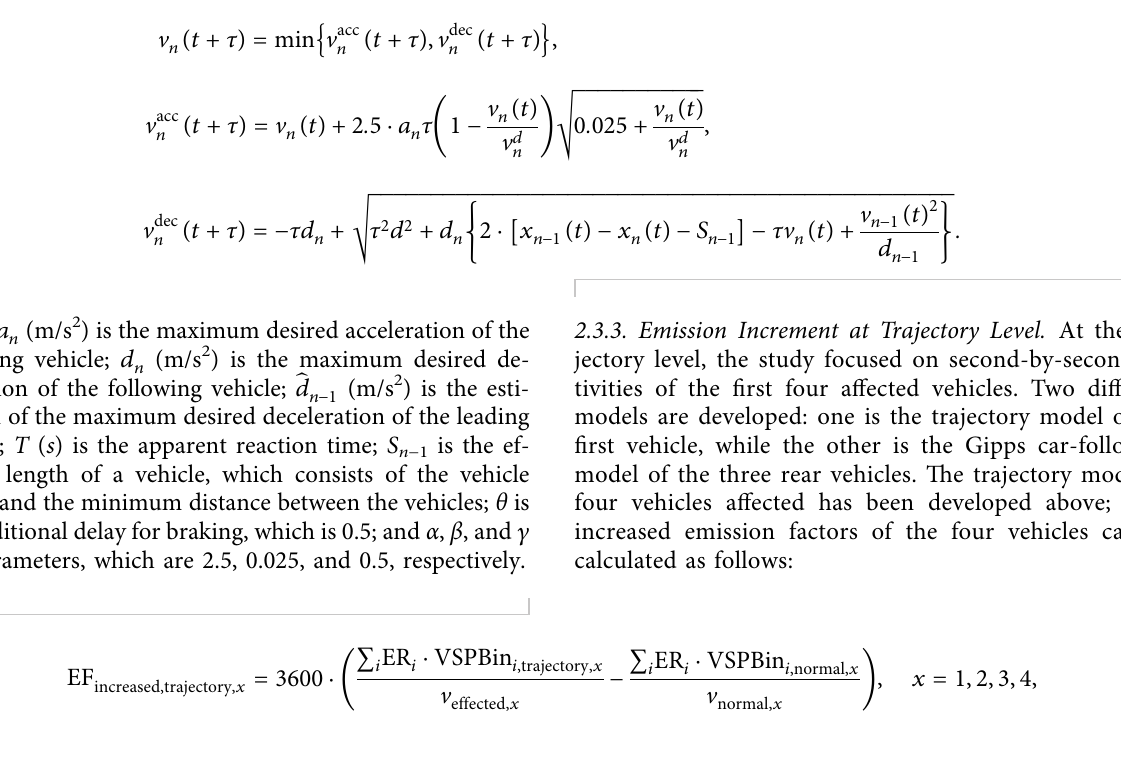
Figure 6: Speed and corresponding acceleration in the low-speed range (with the first and third quantiles). (a) Speed distribution under low- speed range of queuing. (b) Acceleration distribution under low-speed range of